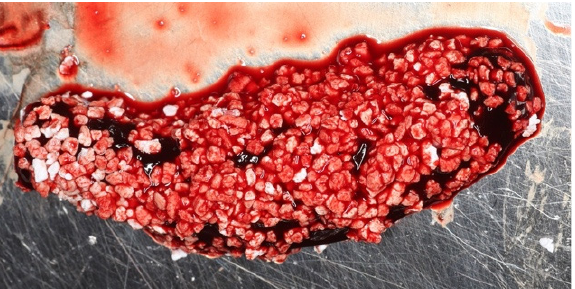
Figure 7. Peripheral blood clot with beta-tricalcium phosphate particles in granules.